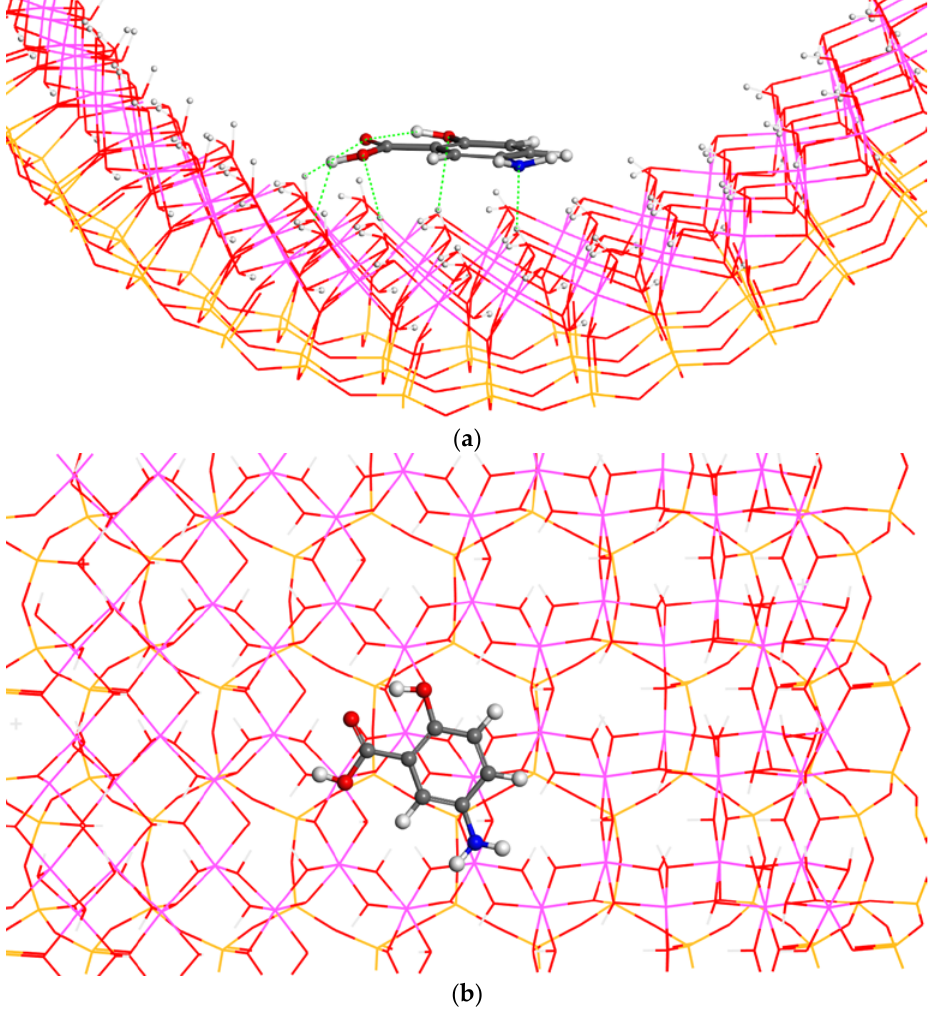
Figure 7. Optimized adsorption complex of the conformer F2 of 5-ASA placed parallel to the surface as well as oriented parallel to the c axis of the halloysite nanotube. Views from the (001) ( a ) and (010) ( b ) crystallographic planes.